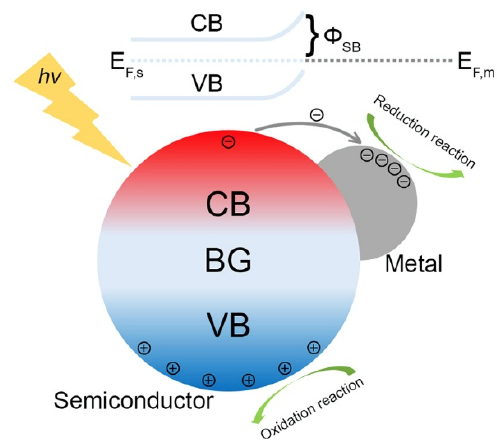
Figure 2. Enhanced charge separation at the metal-semiconductor interface.